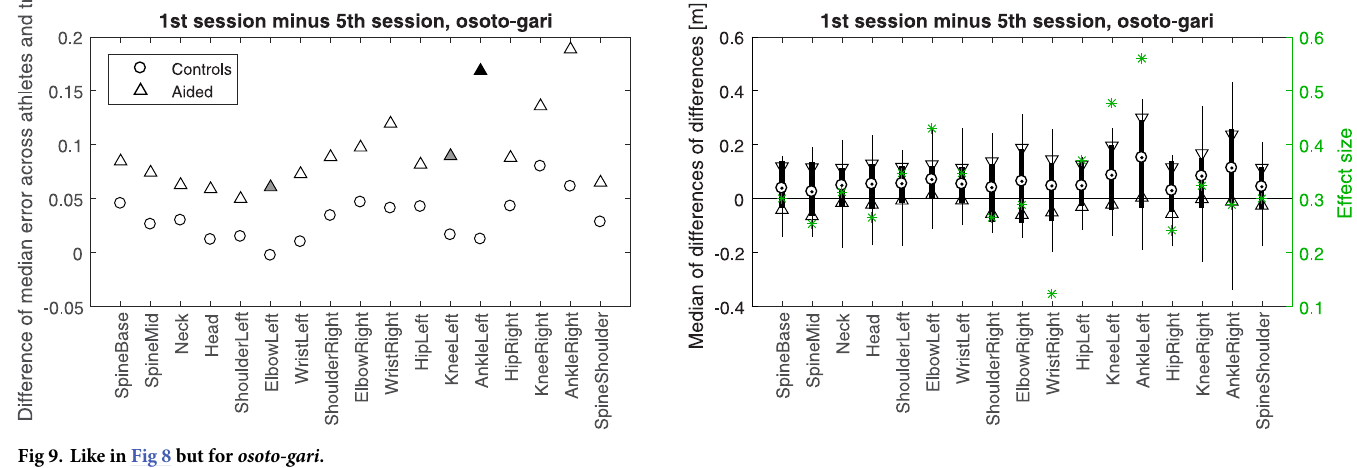
Fig 9. Like in Fig 8 but for osoto-gari